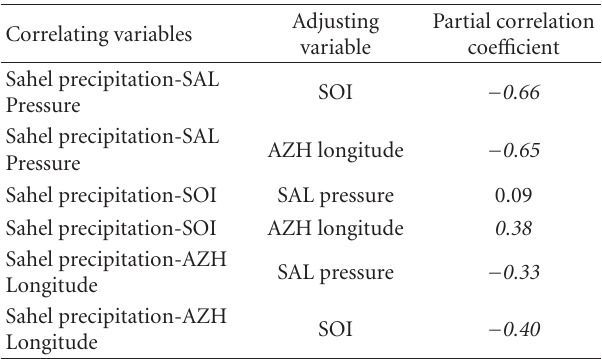
Table 3: Partial correlation analysis for the independent variables identified in Table